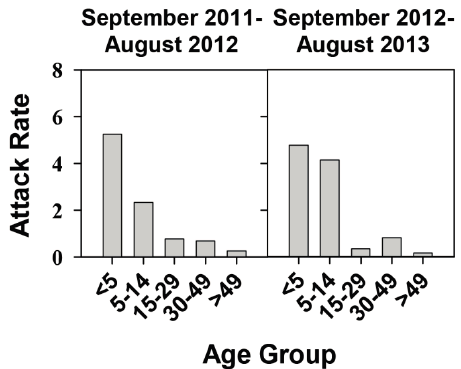
Figure 4. Hepatitis A attack rates of different age groups during September 2011–August 2013 in Catalonia, Spain, in the context of a universal vaccination campaign of preadolescents at the age of 12 years. Data is distributed in two sets: September 2011–August 2012 and September 2012–August 2013. Attack rates are defined as the number of cases per 100,000 inhabitants of each age